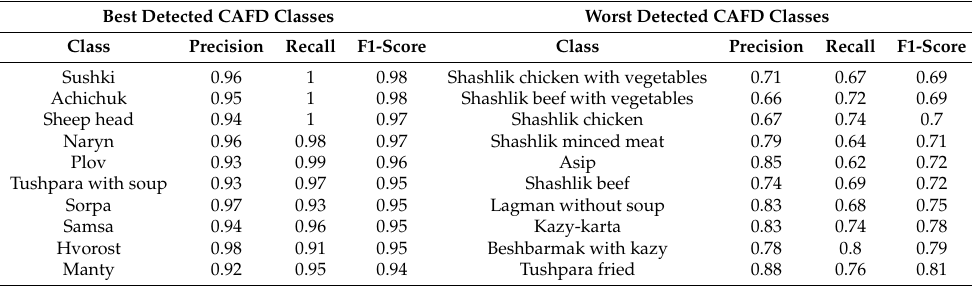
Table 4. Ten CAFD classes best and worst detected by the ResNet152 model.